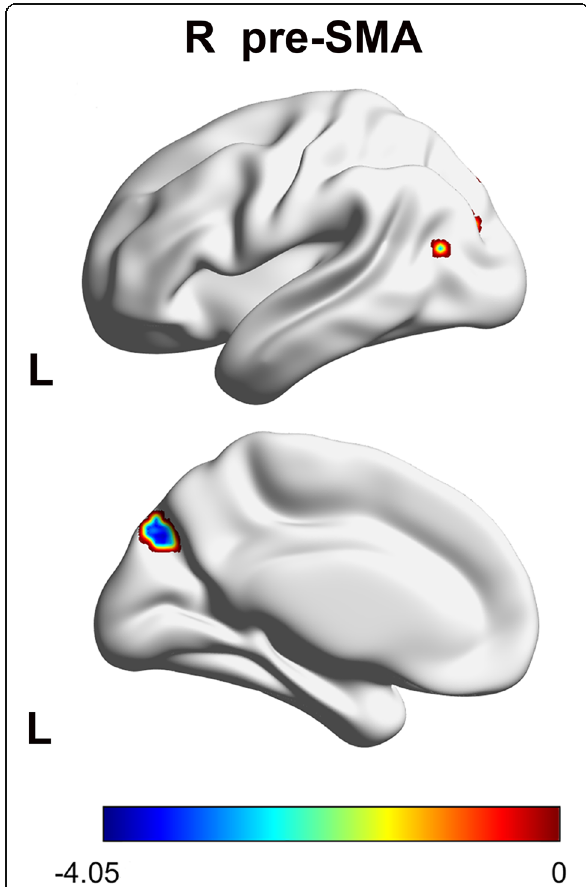
Fig. 3 Sagittal views of the MNI brain areas showing reduced intrinsic functional connectivity (FC) with the preSMA in MWoAs compared to healthy controls. The surviving clusters were assigned thresholds at p < 0.001 (voxel level) and were FWE corrected to p < 0.05 at the cluster